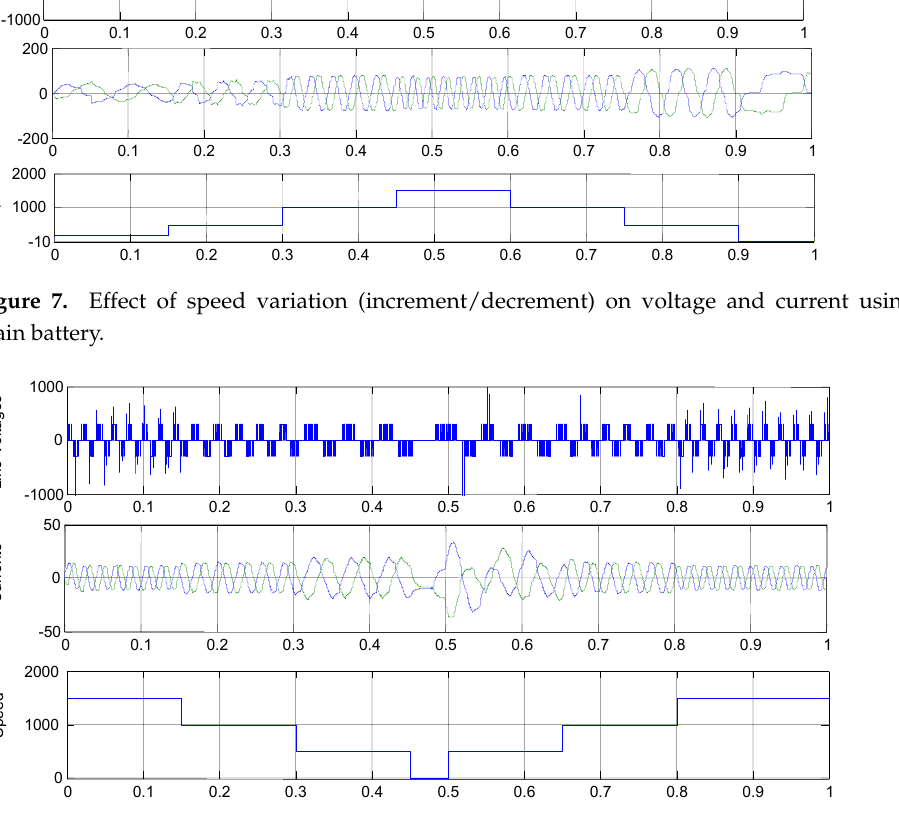
Figure 8. Effect of speed variation (decrement/increment) on voltage and current using the supple- mentary battery.